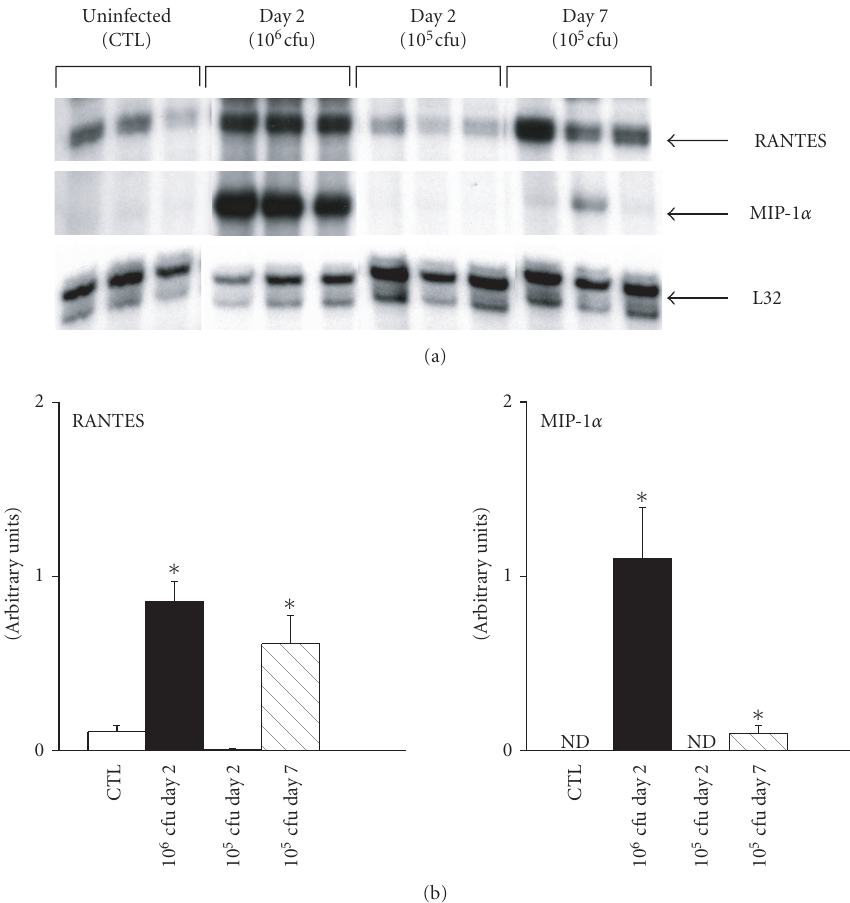
Figure 3: Bacterial dose- and time-dependence of chemokine gene expression in the diaphragm during Pseudomonas lung infection. (a) Representative ribonuclease protection assay data indicating RANTES and MIP-1 α mRNA levels in the diaphragm at two separate time points (Day 2 and Day 7) following intratracheal instillation of Pseudomonas aeruginosa bacteria into the lungs at di ff erent doses (5 × 105 or 1 × 106 cfu). (b) Quantification of RANTES and MIP-1 α gene expression under the above conditions. Note that only the higher inoculating dose of bacteria led to measurable chemokine upregulation at Day 2, while the lower dose was also able to induce a significant increase in RANTES gene expression by Day 7 postinfection. All data are group means ± SE, n = 6 mice per group. Data are normalized to the L32 housekeeping gene. ∗ P < . 05 for comparisons to the sham control (CTL) condition. ND = signal not